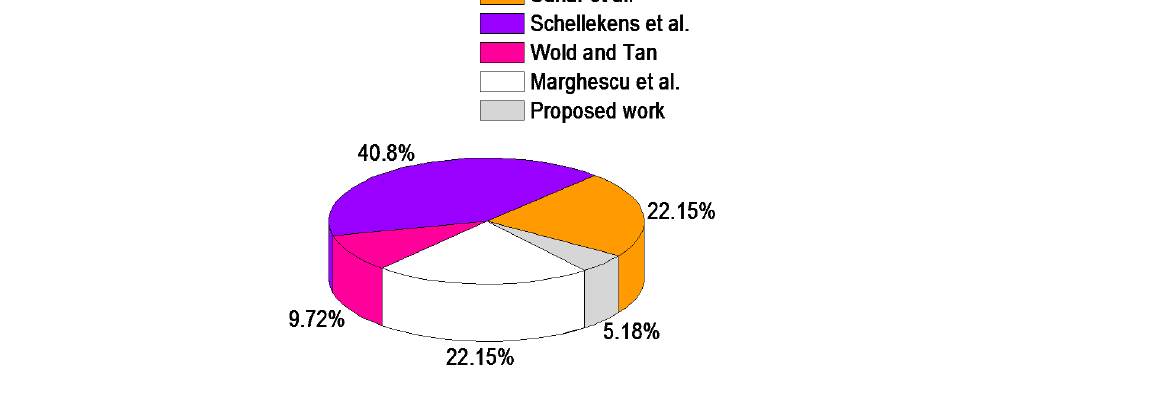
Figure 9. Performance comparison: Number of inverters [18,19,23,30]. Table 10. Performance comparison: Hardware resources.